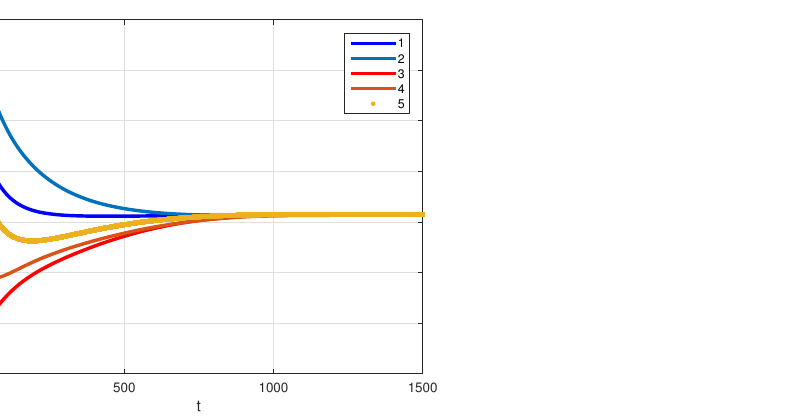
Figure 7. The evolution dynamics of susceptible and exposed population against time, using initial state values and R 0 = 2.1429 > 1.